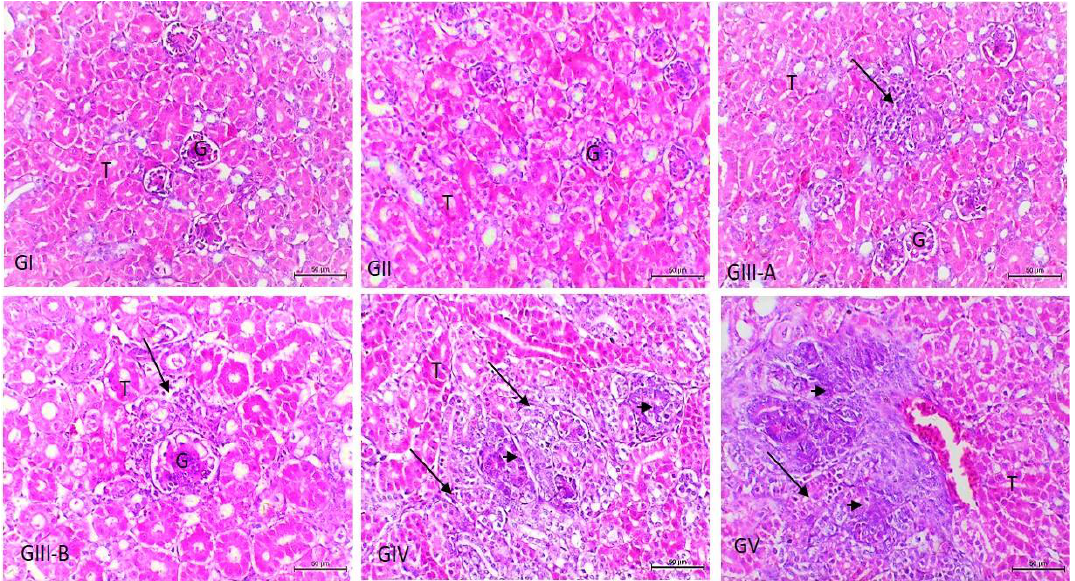
Figure 3. Photomicrograph of kidney sections from experimental groups stained with Hx & E stain. GI and GI1: kidneys show intact glomeruli ( G ) and renal tubules (T). GIII-(A and B): kidneys show slight interstitial and periglomerular mononuclear cell infiltration (arrow). GIV and GV: there was heavy interstitial and periglomerular mononuclear cell infiltration (arrow) and slight tubular basophilia (arrowhead). The bar size of each picture is included under each picture.